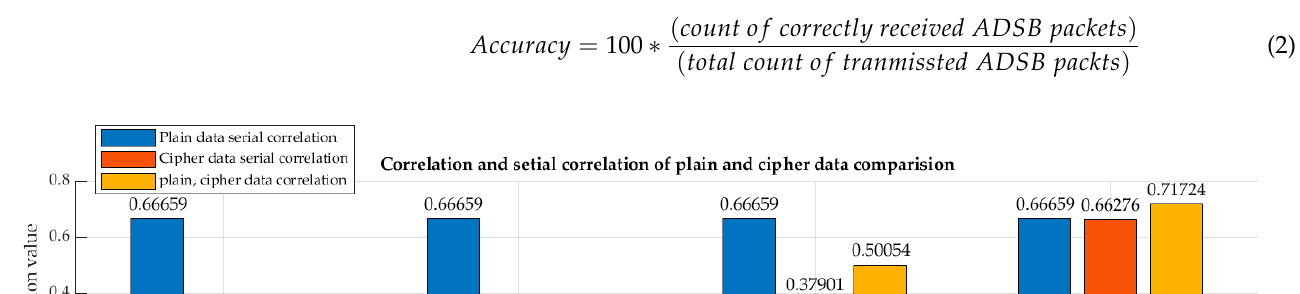
Figure 9. Correlation and serial correlation of plain and cipher data.